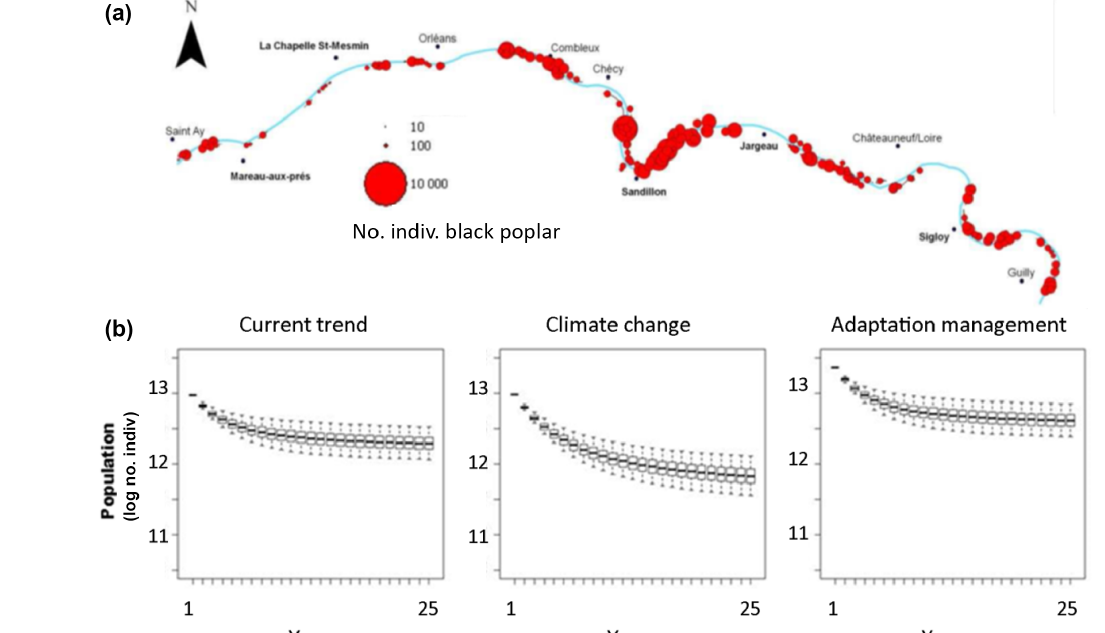
Figure 3. LTER sites answer specific ecological questions, for which specific data are gathered, e.g. black poplar population persistence under climate change. Black poplar population strength along the French Loire River section (a) and model projections (b) under current, climate change, and adaptation management scenarios (Van Looy and Piffady,